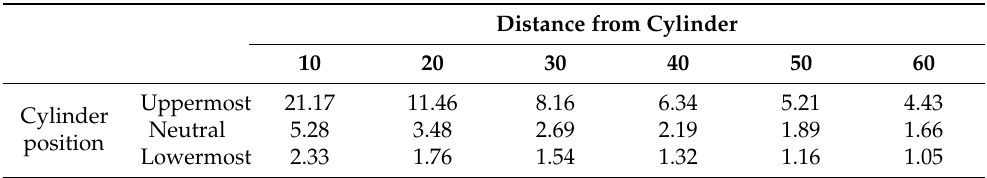
Table 4. Mean L/D cycle frequencies (s − 1 ) obtained for the uppermost, neutral and lowermost cylinder positions.